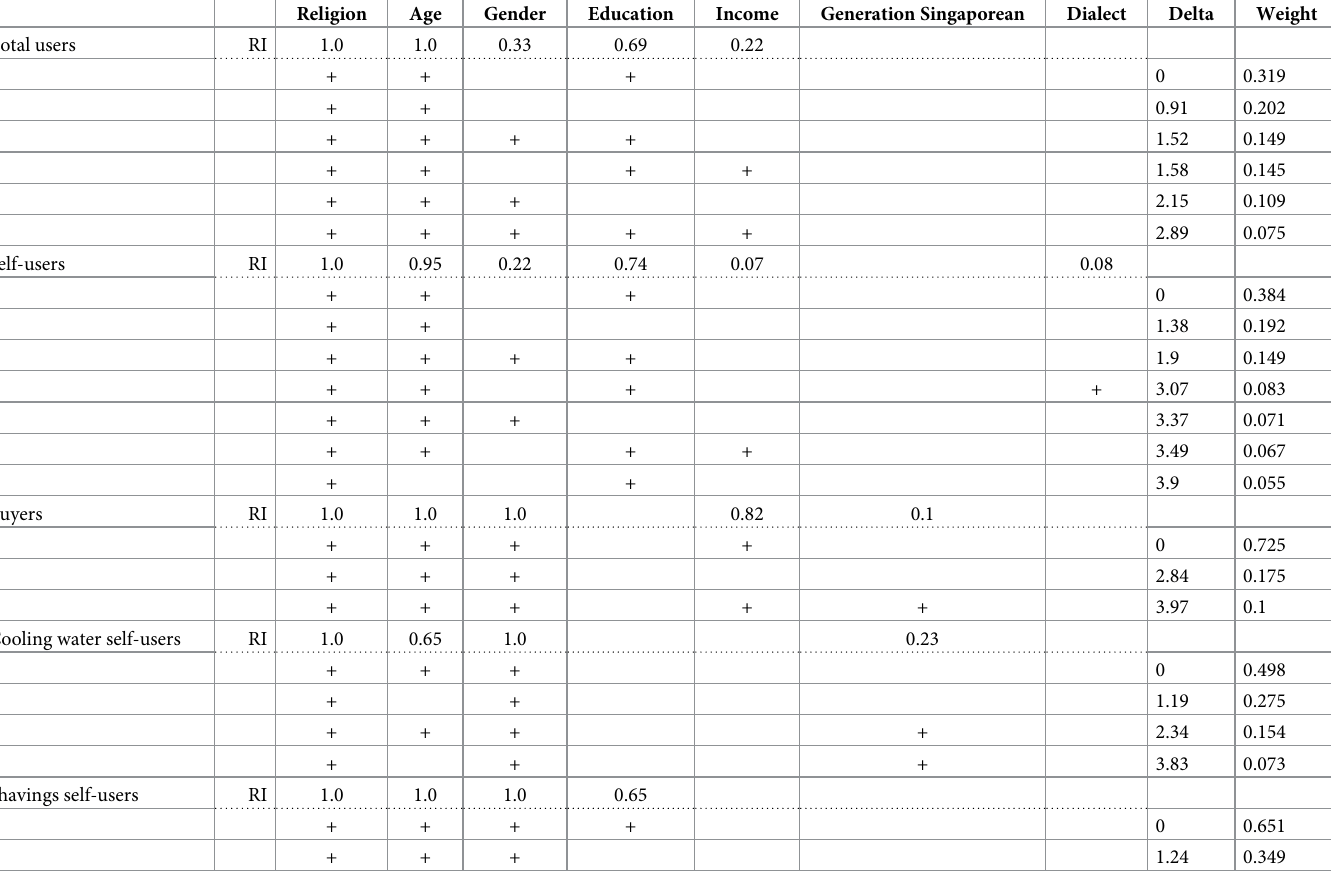
Table 2. Combined model selection table for all consumer sub-groups, showing dredge models with a delta < 4, and the Relative Importance (RI) of the variables in each averaged-model. Religion Age Gender Education Income Generation Singaporean Dialect Delta